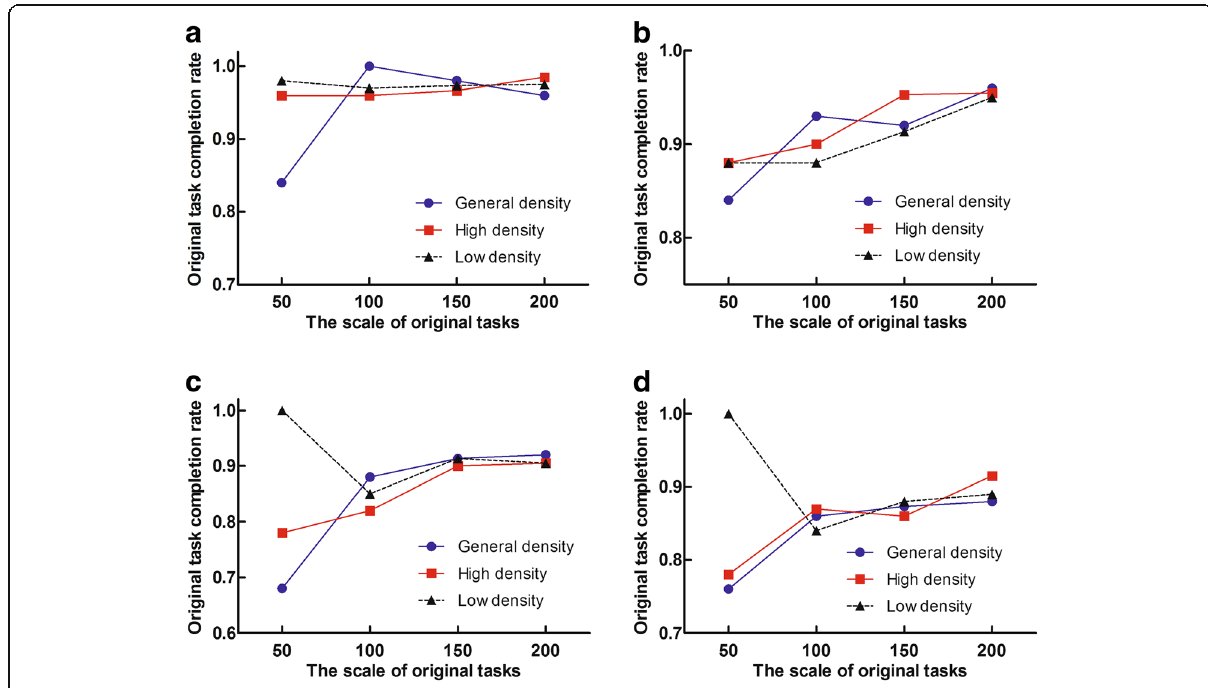
Fig. 7 The completion of original tasks ( a , b , c , d